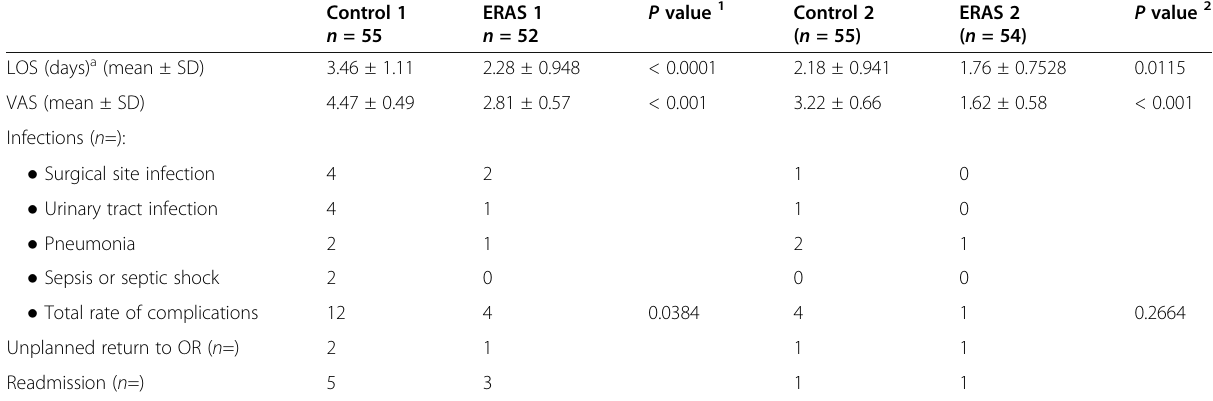
Table 2 Operative and postoperative